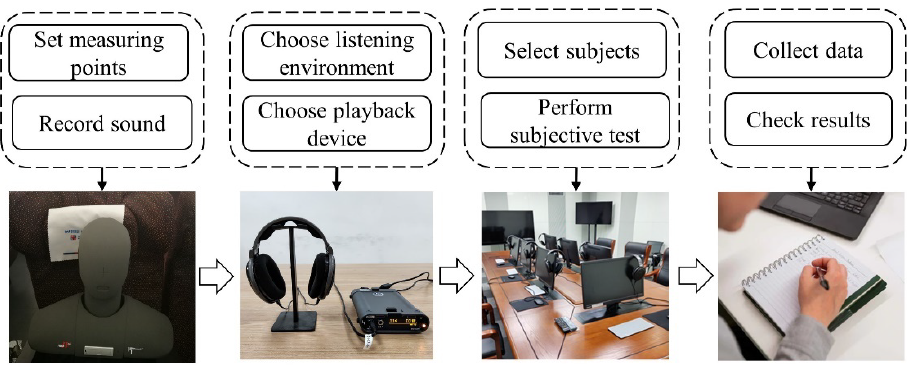
Figure 4. Subjective evaluation process.